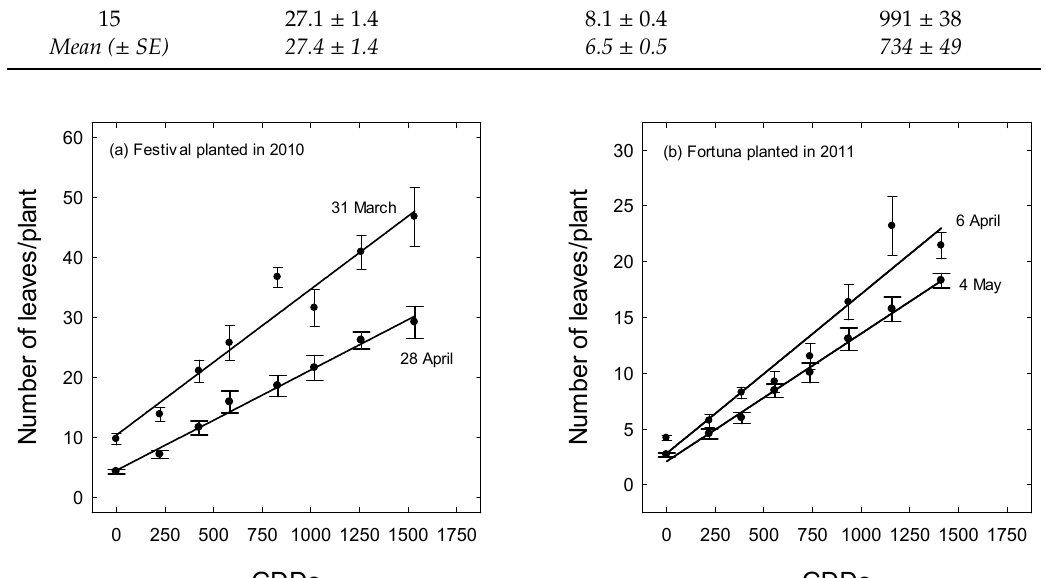
Figure 2. Changes in leaf production in ( a ) ‘Festival’ and ( b ) ‘Fortuna’ strawberries planted at two different times with growing degree-days (GDDs) in Queensland in 2010 and 2011. The base temperature used to calculate GDD was 7 °C. Data are the means and standard errors (SEs) of four replicates per treatment. The early and late plantings of ‘Festival’ in 2010 relate to Experiments 7a and 7b, while the early and late plantings of ‘Fortuna’ in 2011 relate to Experiments 10a and 10b. Linear models are